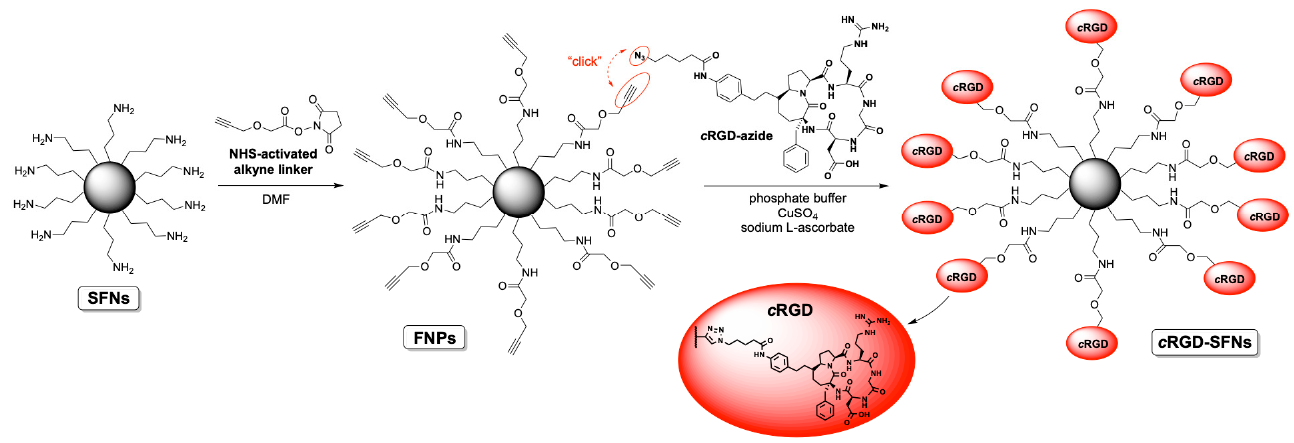
Figure 2. Scheme of SFNs functionalization with RGD.